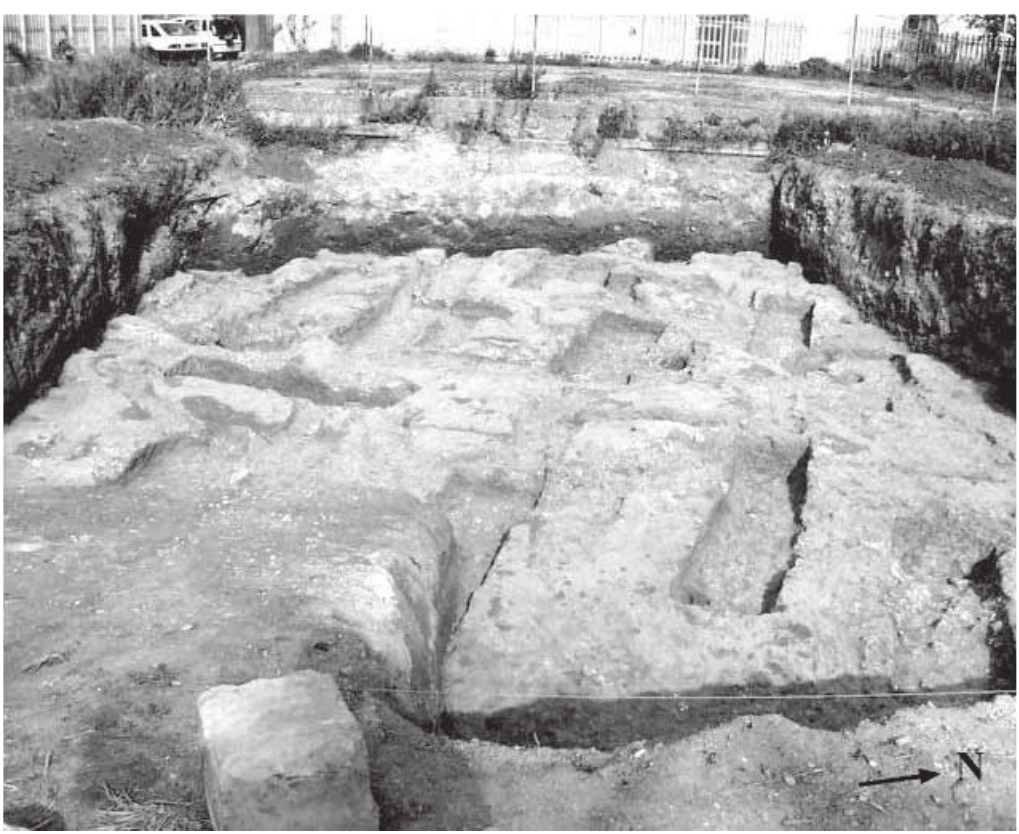
Fig. 11. Photo of the excavation results from Test 6: artificial cuts in the bedrock interpreted as ancient (maybe Messapian) quarry